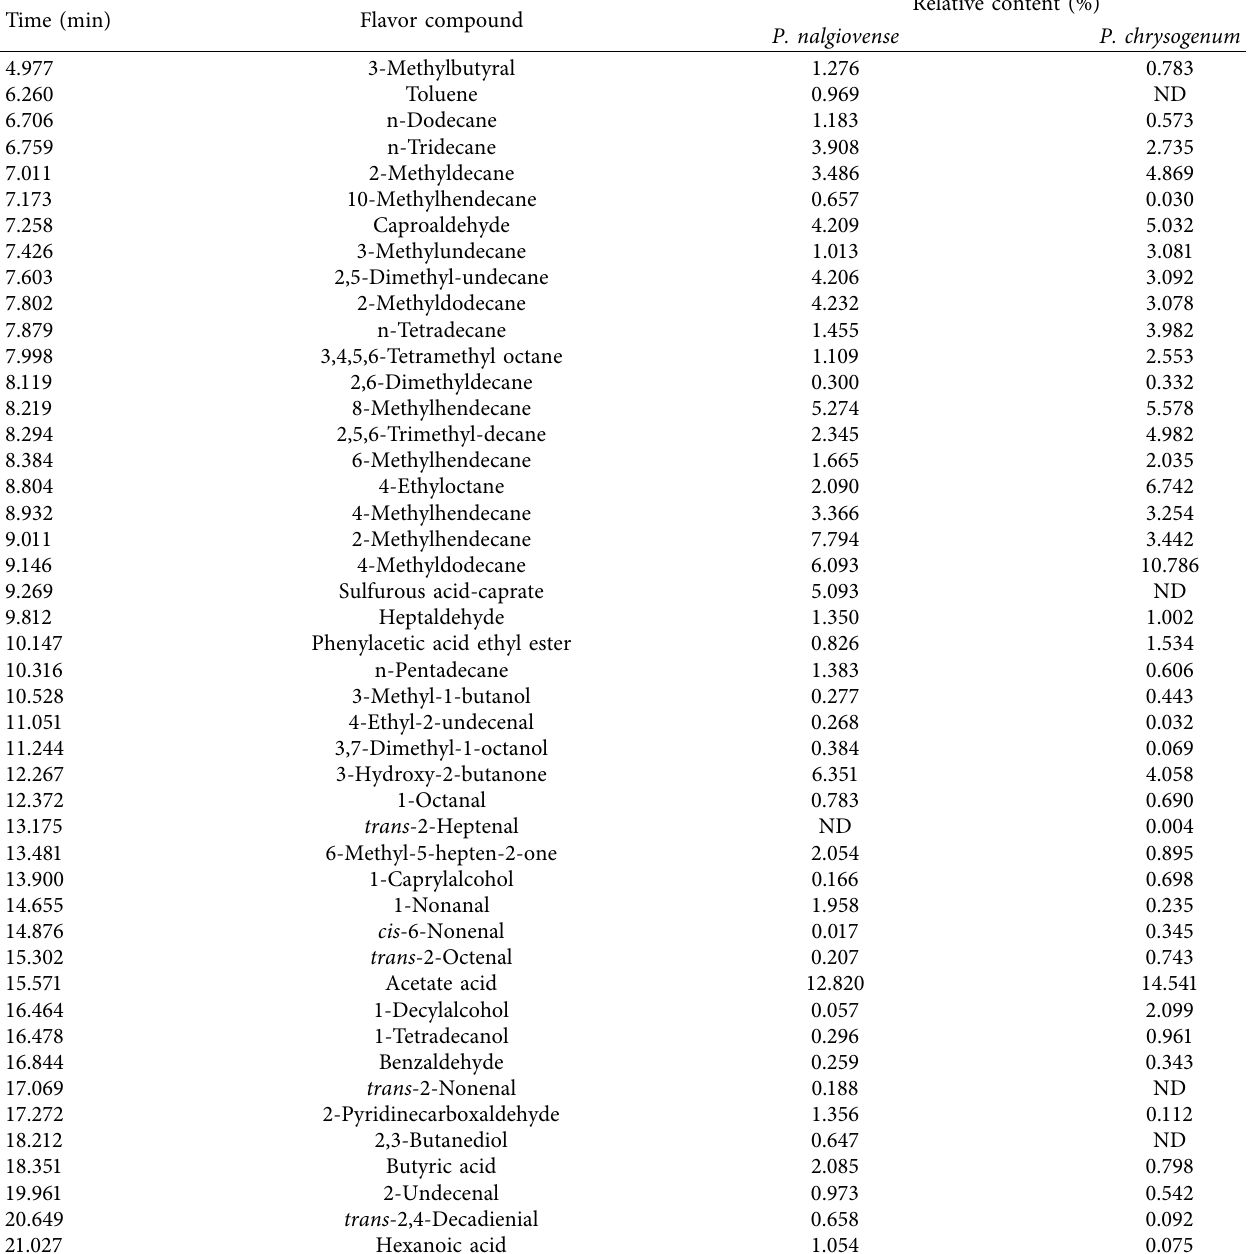
Relative content